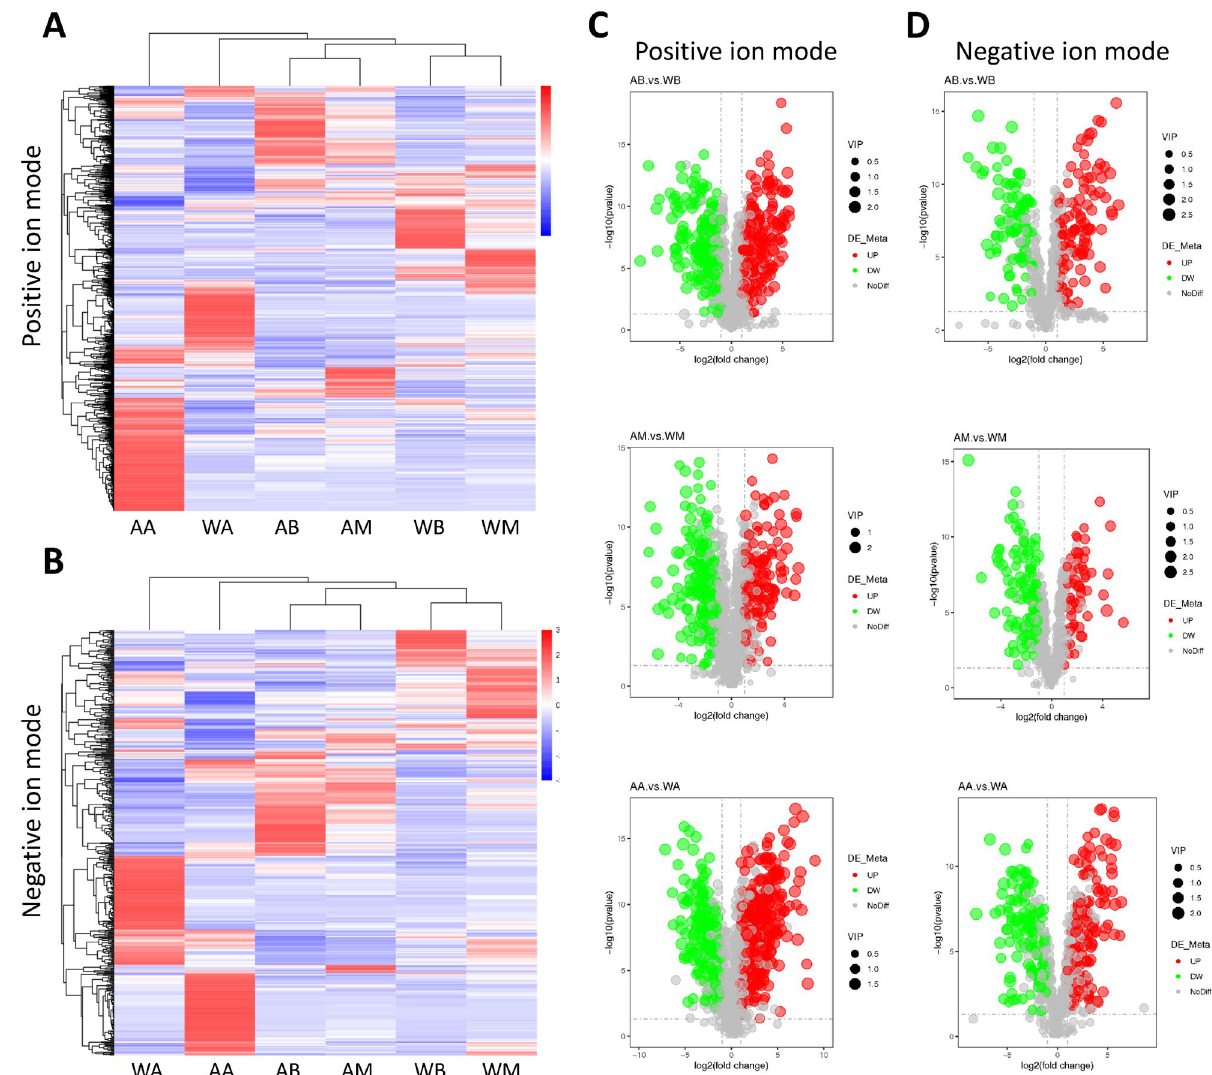
Figure 2. Metabolite profiling of different growth periods of fruiting bodies of cultivated and wild Inonotus hispidus are compared at budding, mature and aging stages (the data used in heatmaps are Z-score of expressions). Note: AB, AM, and AA are samples of fruiting bodies of cultivated Inonotus hispidus in budding, mature and aging growth periods, respectively. WB, WM, and WA are samples of fruiting bodies of wild Inonotus hispidus in budding, mature and aging growth periods, respectively. Heat map of cultivated Inonotus hispidus in positive ion mode ( A ), negative ion mode ( B ). Each fruiting bodies sample is visualized in a single column and each metabolite is represented by a single row. blue colors indicate lower metabolite concentration, while red colors show enhanced metabolite levels. Volcano plot in positive ion mode ( C ), negative ion mode ( D ). Each point in the Volcano plot represents a metabolite, with significantly up-regulated metabolites represented by red dots and significantly down-regulated metabolites represented by green